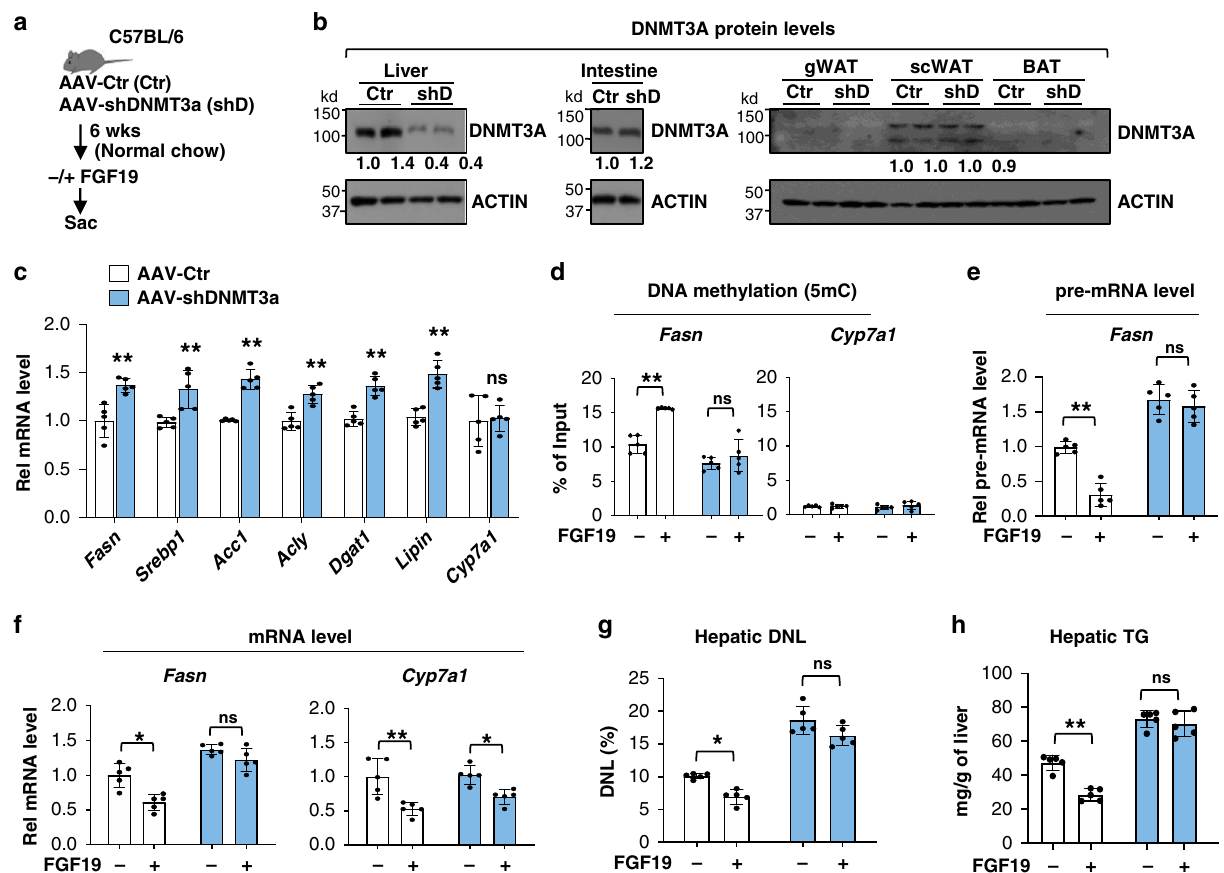
Fig. 4 FGF19-mediated DNA methylation and repression of hepatic lipogenesis are attenuated by liver-speci fi c downregulation of DNMT3A. a Experimental outline. C57BL/6 mice were infected with AAV-shDNMT3A (blue bars) or AAV-empty (Ctr, white bars) and 6 weeks later, fasted for 12 h and then treated with FGF19 or vehicle for 2 h for MeDIP and 2 h or 6 h for RT-qPCR detecting pre-mRNA or mRNA, respectively. b DNMT3A expression in the liver, intestine, and adipose tissues determined by IB. c The mRNA levels of lipogenic genes determined by RT-qPCR. d DNA methylation at the Fasn and Cyp7a1 promoters determined by MeDIP. Samples from two mice for each group are shown. The experiment was done once. e , f Fasn pre-mRNA and mRNA levels and Cyp7a1 mRNA levels determined by RT-qPCR. g , h C57BL/6 mice were infected with AAV-shDNMT3A or AAV-empty (Ctr) and 6 weeks later were treated daily with vehicle or FGF19 and given 4% deuterated drinking water for 2 days. Hepatic de novo lipogenesis (DNL) and TG levels measured as described in Methods. c – h The mean values ± SD are plotted ( n = 5 mice). Statistical signi fi cance was determined by ( c ) two-tailed Student ’ s t test or ( d - h ) two-way ANOVA with the Tukey post-test. * P < 0.05, ** P < 0.01, ns, statistically not signi fi